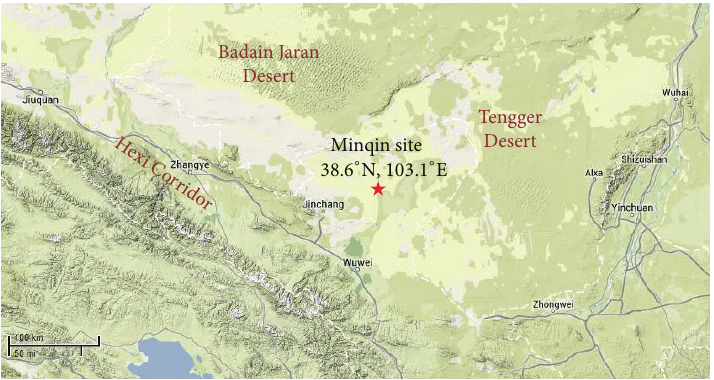
Figure 1: Geographical location of Hexi Corridor, Badain Jaran Desert, and Tengger Desert. The Minqin site (38.6 ∘ N, 103.1 ∘ E) is marked as a red